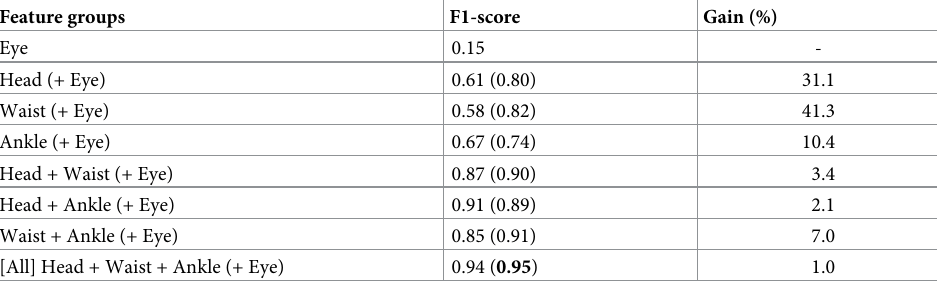
Table 5. Ablation study for locomotion (addition of eye-tracking). Using eye-tracking data only shows little influ- ence on locomotion. However, when eye-tracking data are combined with other data modalities, they served as a strong supplement to improve the performance of the